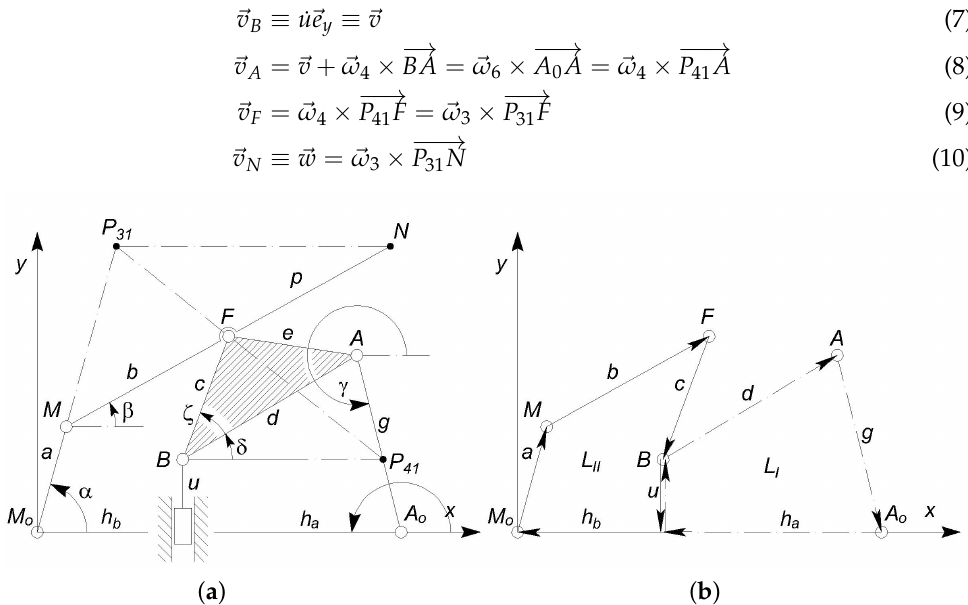
Figure 6. The nomenclature adopted to define the PRBM ( a ) and two independent vector loops L I and L II ( b ).